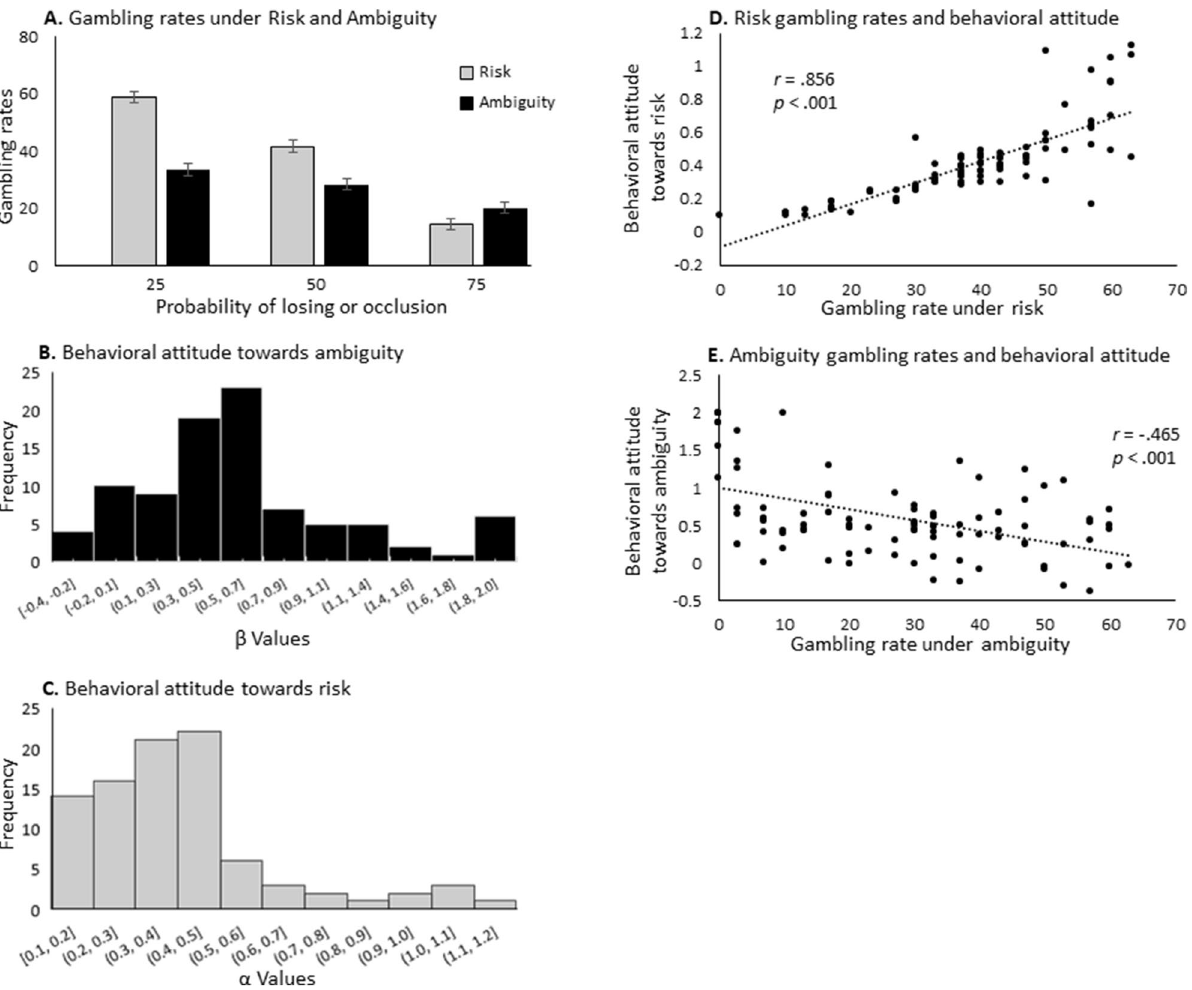
Figure 2. Behavioral attitudes towards risk and ambiguity. ( A ) Gambling rates in ambiguous (black) and risky (gray) trials under three different outcome probabilities. Across the two conditions, lower losing probabilities and lower occlusions were associated with higher gambling rates. ( B and C ) Behavioral attitudes towards ambiguity (β) and risk (α) were calculated using a maximum utility model 37 . ( D ) Positive association between gambling rates in risky trials and model-based risk avoidance parameter (α). ( E ) Negative association between gambling rates in ambiguous trials and model-based ambiguity avoidance parameter